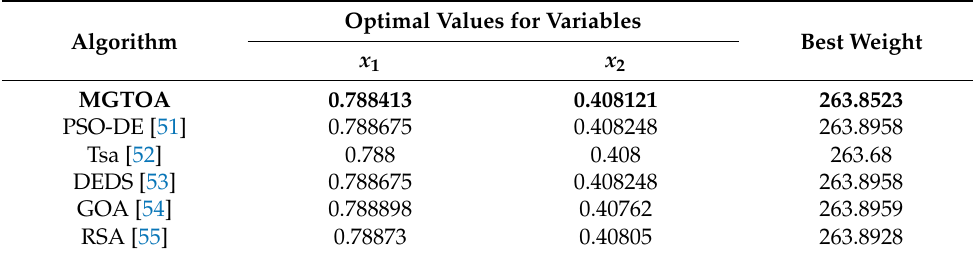
Table 13. Experimental results of Three-Bar Truss Design.